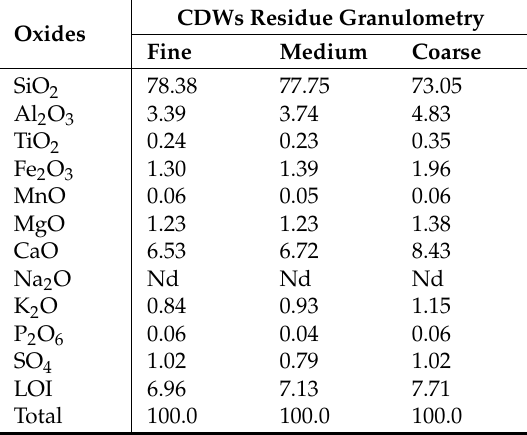
Table 2. X ‐ ray fluorescence (XRF) chemical analysis for CDW. Table 2. X-ray fluorescence (XRF) chemical analysis for CDW. Oxides CDWs Residue Granulometry Oxides